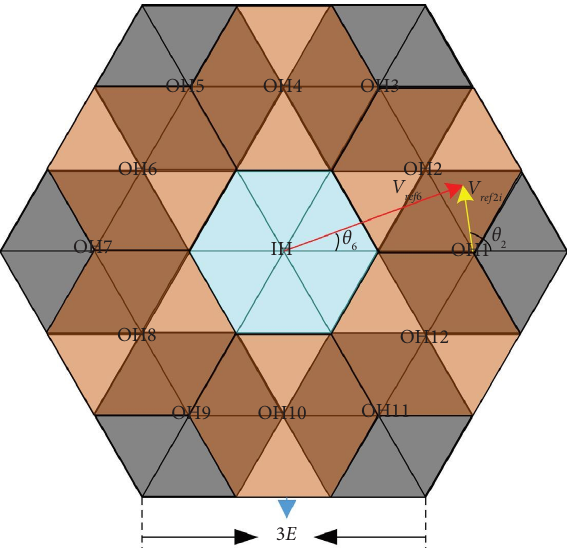
Figure 6: Disintegration of 4L SVD to 2L